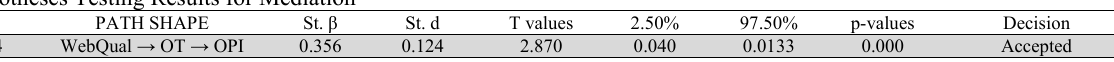
Hypotheses Testing Results for